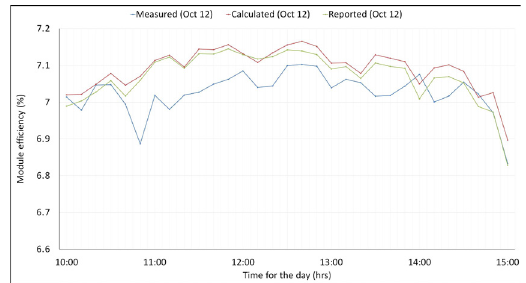
Figure 4. E ffi ciency for monsoon day, 12 th July of a-Si PV tech- nology.